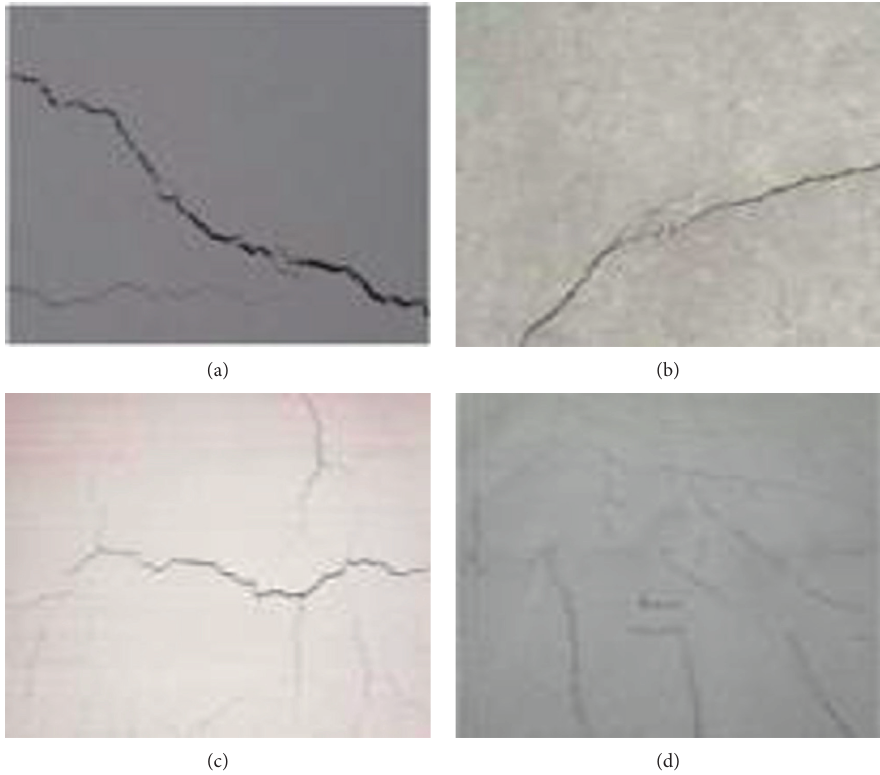
Figure 18: Four crack images to be percolated: (a) image 1; (b) image 2; (c) image 3; (d) image